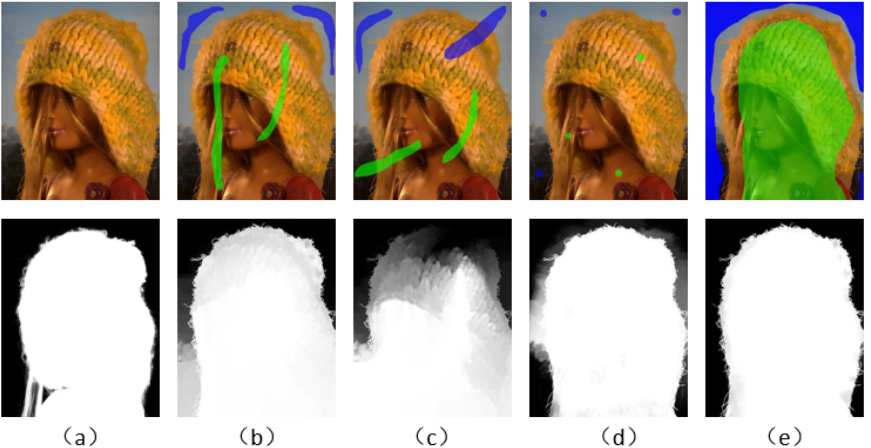
Figure 1. Existing image matting methods require the user to design additional constraints for specifying the foreground and background color samples. ( a ) Original image and groundtruth alpha matte. ( b – e ) The first row, from left to right shows different constraint information provided by the user. The second row shows their respective predicted alpha